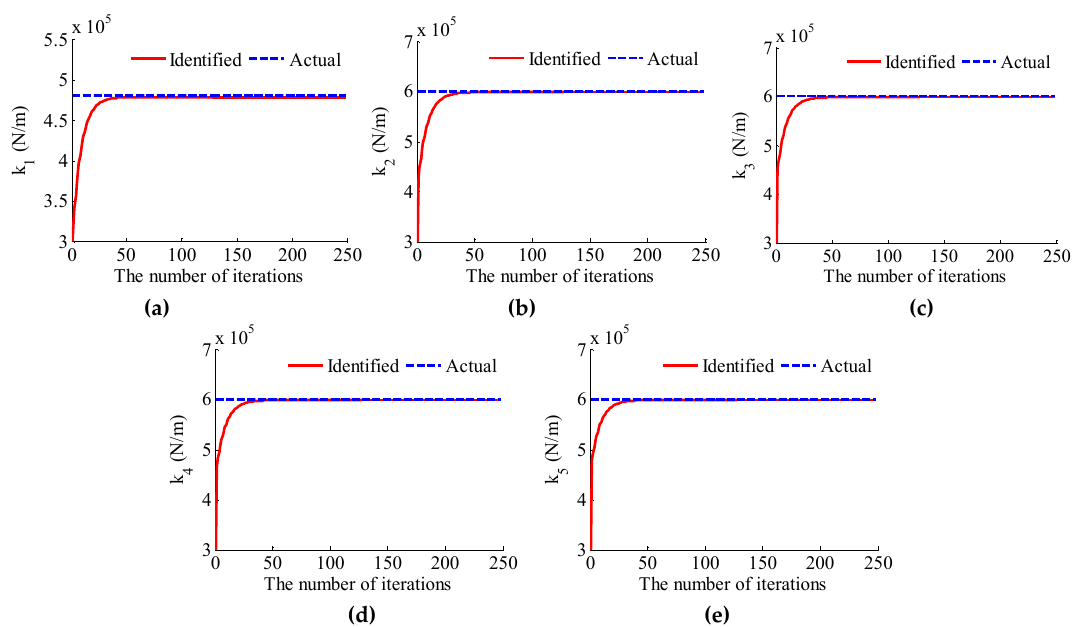
Figure 4. The identified structural parameters (10% noise): ( a ) k 1 ; ( b ) k 2 ; ( c ) k 3 ; ( d ) k 4 ; ( e ) k 5 .